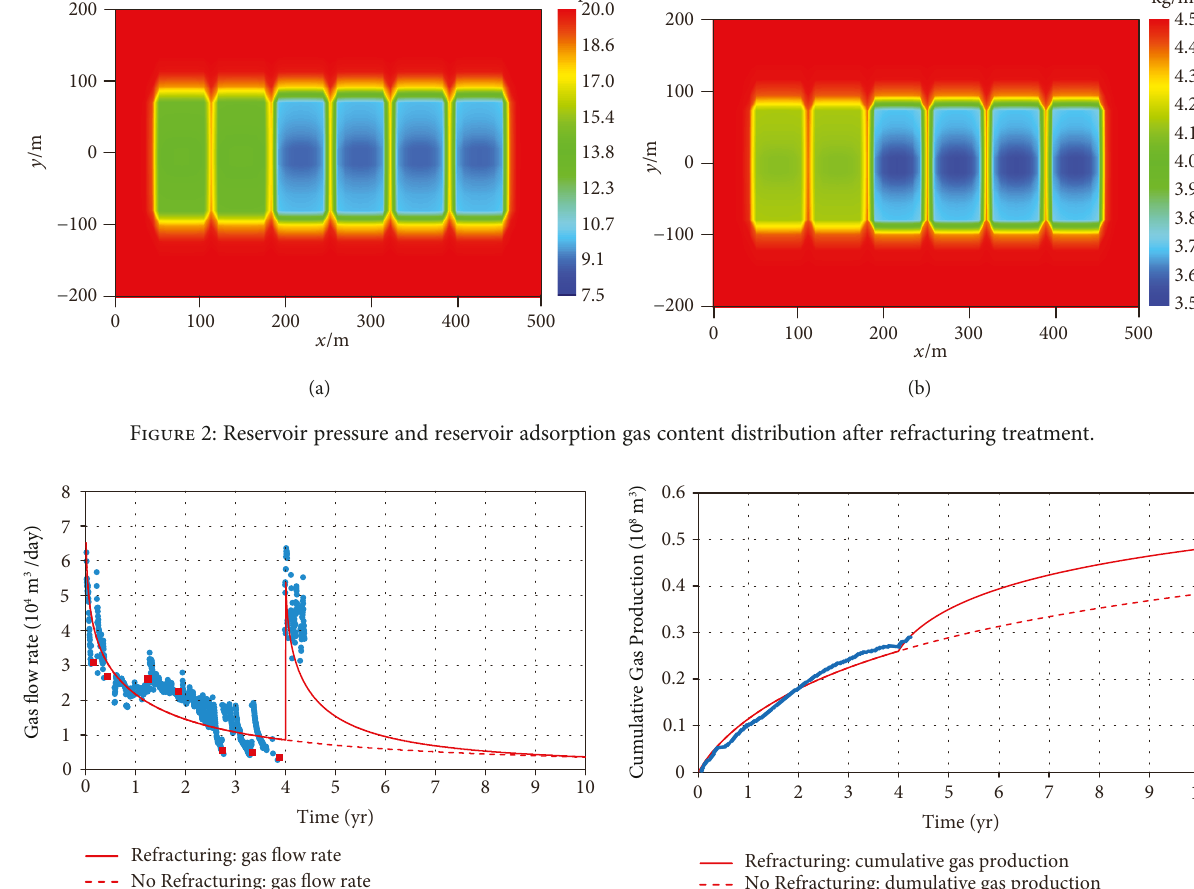
Refracturing: gas flow rate